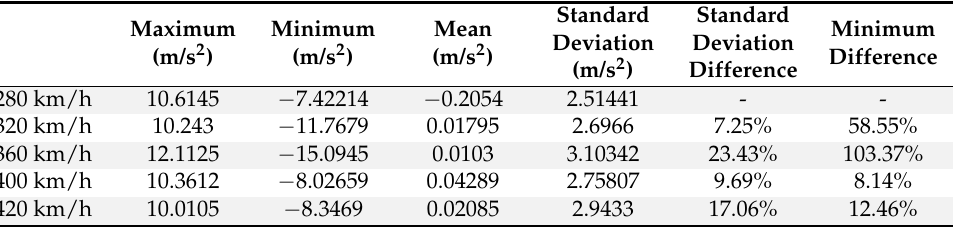
Table 5. Statistical results of vertical acceleration of the contact strip passing through tunnel at different speeds.